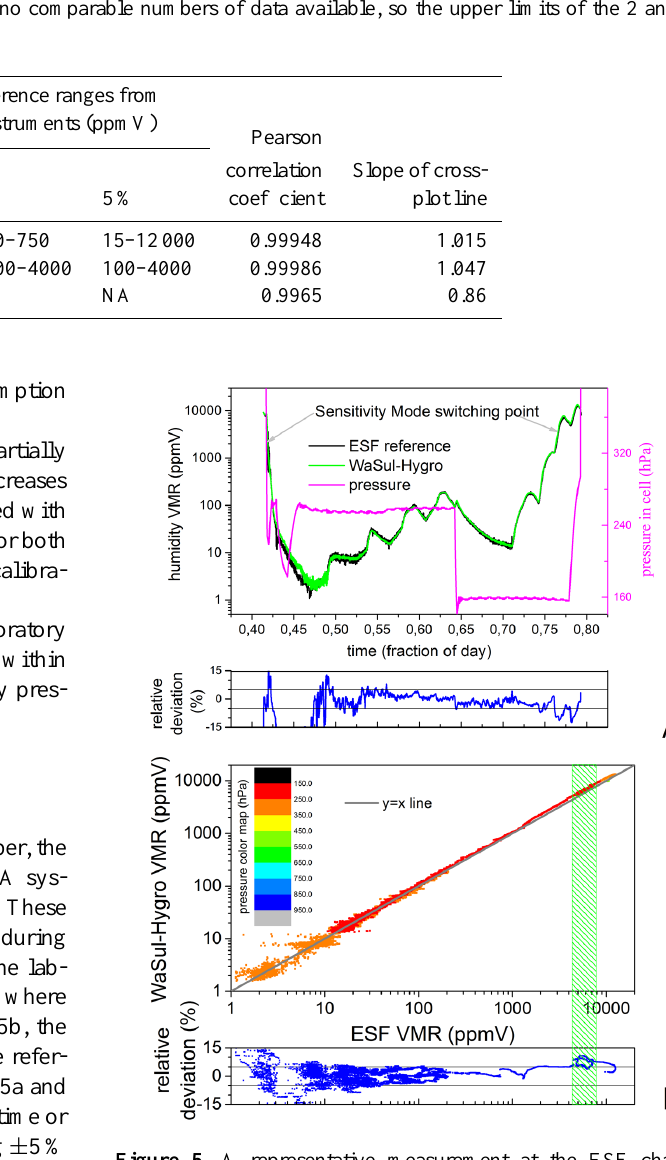
Figure 5. A representative measurement at the ESF chamber (5 May 2011). (a) is the time series of the measurements; (b) is the corresponding cross plot, where the pressure is coded by color and the green shaded area indicates the omitted loopy